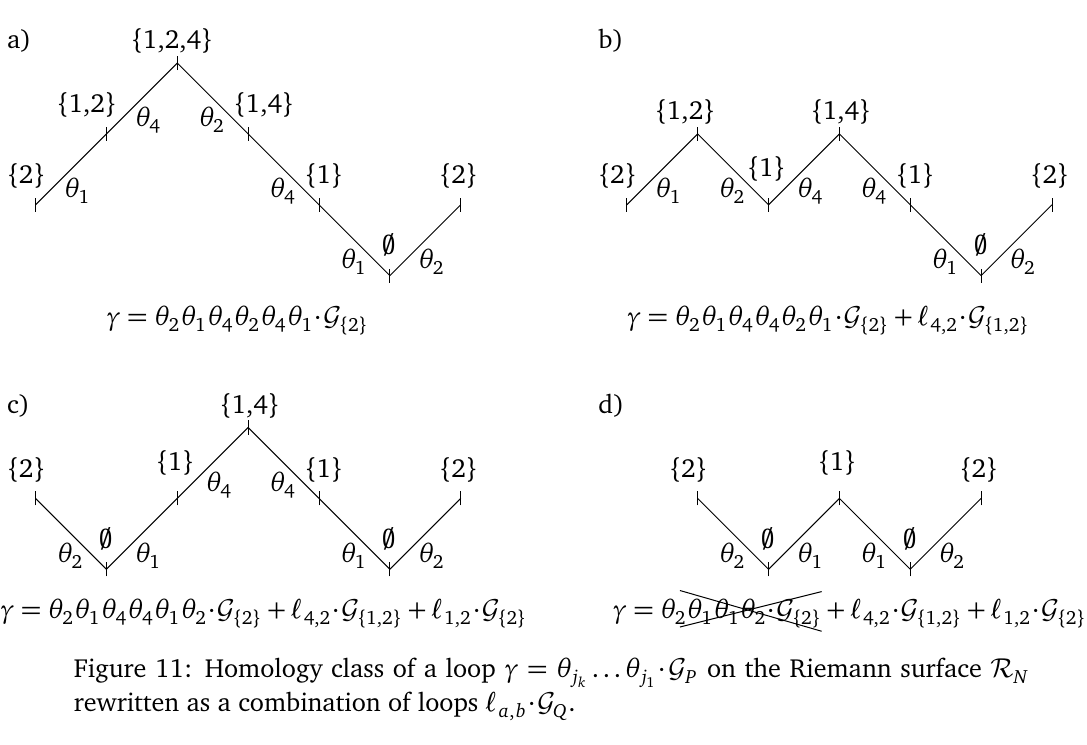
Figure 11: Homology class of a loop γ = θ